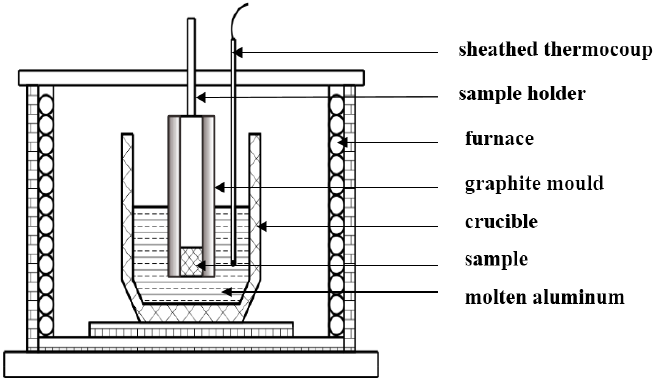
Figure 1. Schematic diagram of the corrosion test device.